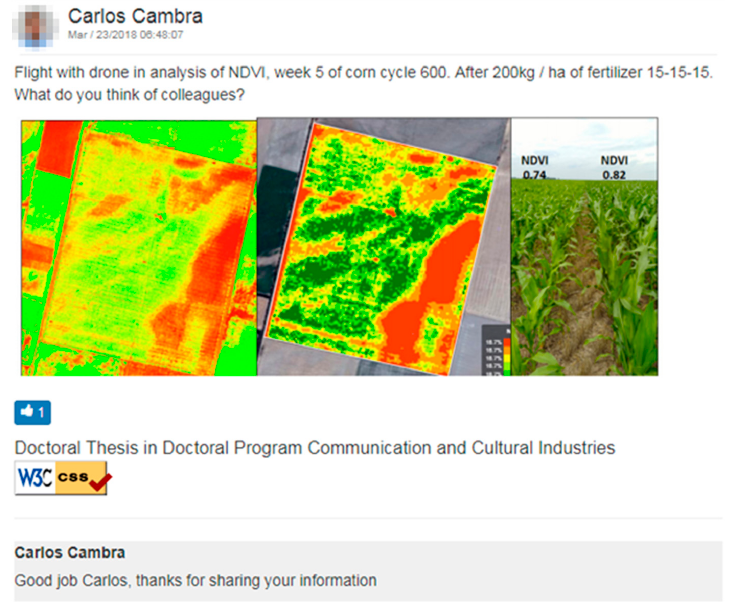
Figure 15. User post sharing NDVI results.